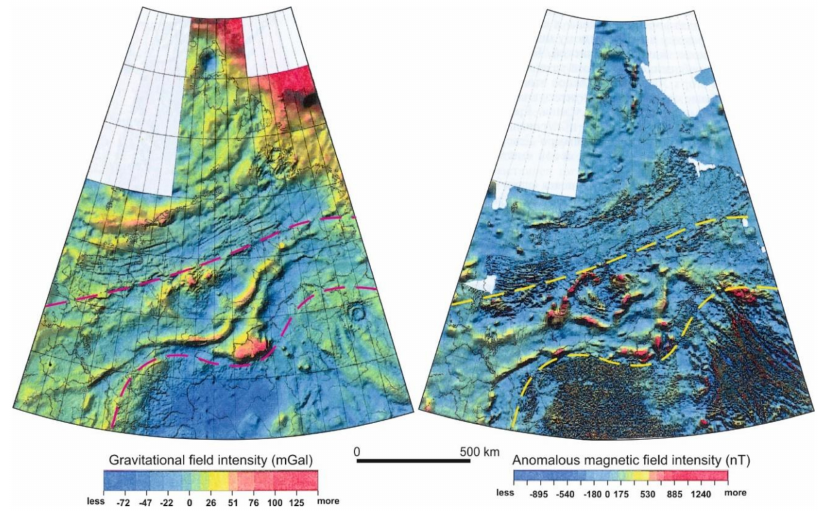
Figure 8. Maps of the gravitational field and anomalous magnetic field anomalies for the Severnaya Zemlya—Taimyr Peninsula region from Reference [69] with our simplifications. Magenta and yellow dashed lines show the approximate boundaries of the Yenisei-Khatanga